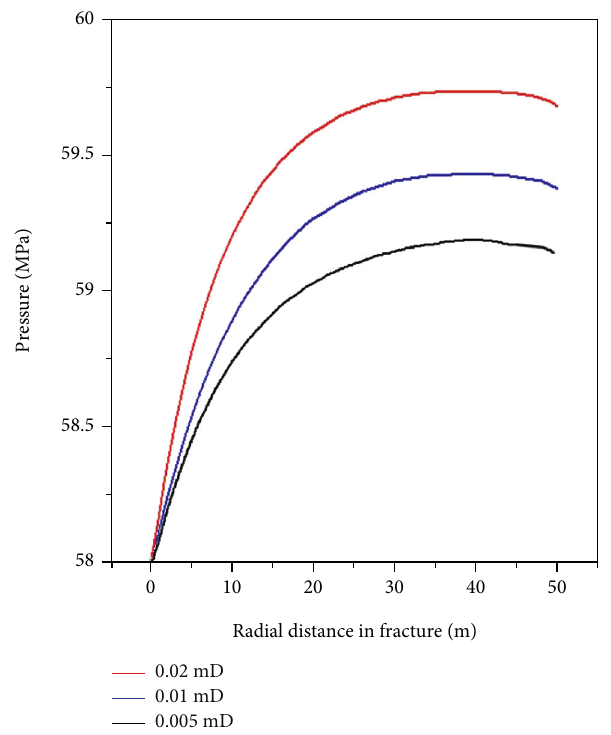
Figure 7: In fl uence of matrix permeability ( k ) on pressure drop funnel in